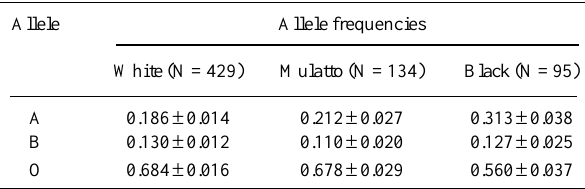
Table IV - Distribution of glutathione S-transferase M1 allele frequencies in racial sub-groups of the Rio de Janeiro sample. Allele Allele frequencies White (N =